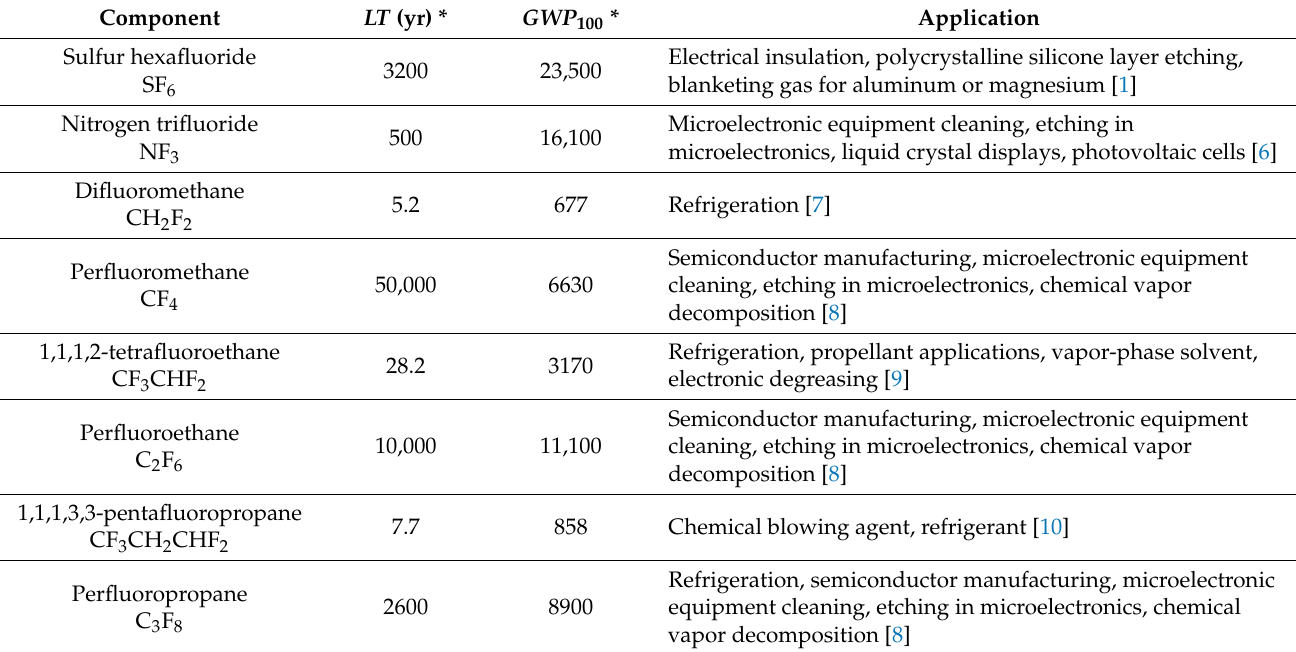
Table 1. The lifetime ( LT ) in the atmosphere, global warming potential values in a 100-year horizon ( GWP 100 ), and applications of SF 6 and other fluorinated greenhouse